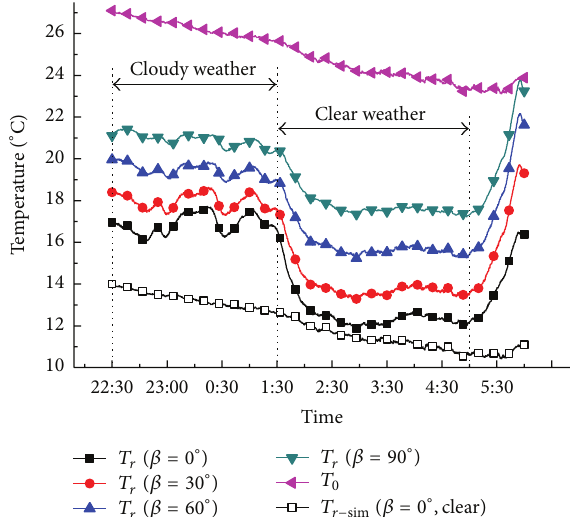
Figure 7: Testing results from 22:30, May 29, to 6:00, May 30, 2014.